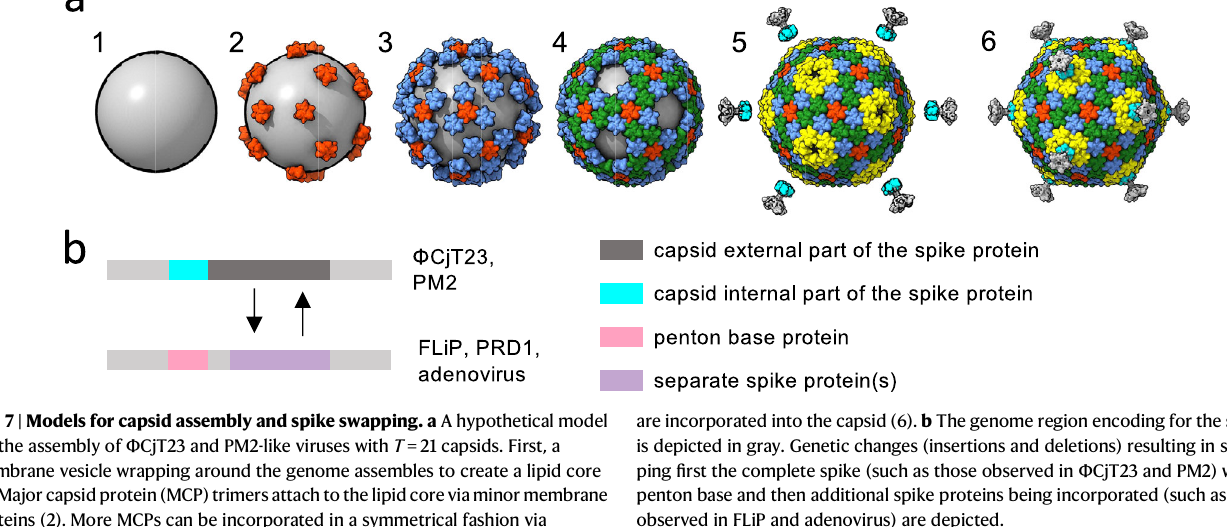
are incorporated into the capsid(6). b The genome region encoding for the spikes is depicted in gray. Genetic changes (insertions and deletions) resulting in swap- ping fi rst the complete spike (such as those observed in Φ CjT23 and PM2) with a penton base and then additional spike proteins being incorporated (such as those observed in FLiP and adenovirus) are